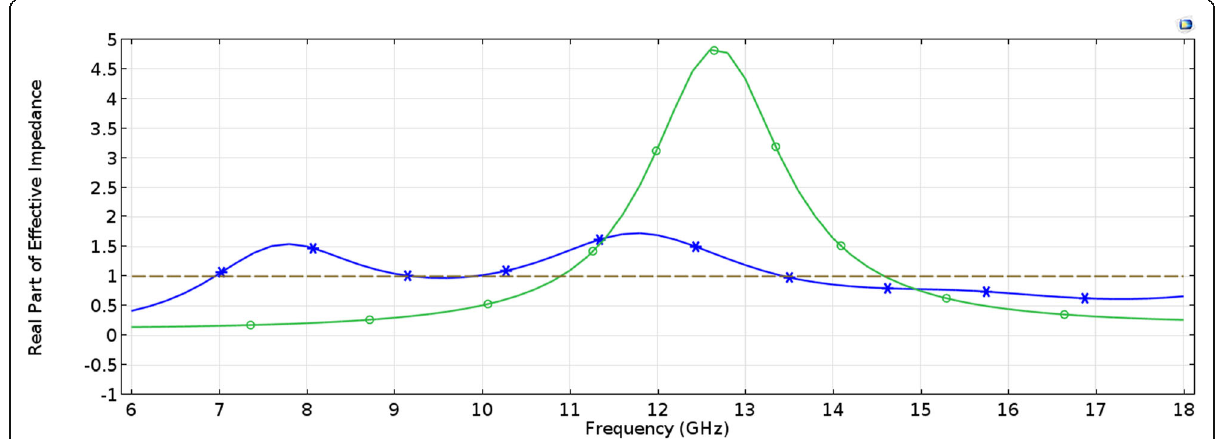
Fig. 12 Calculated real effective impedance plots of metastructure absorber and flat absorber